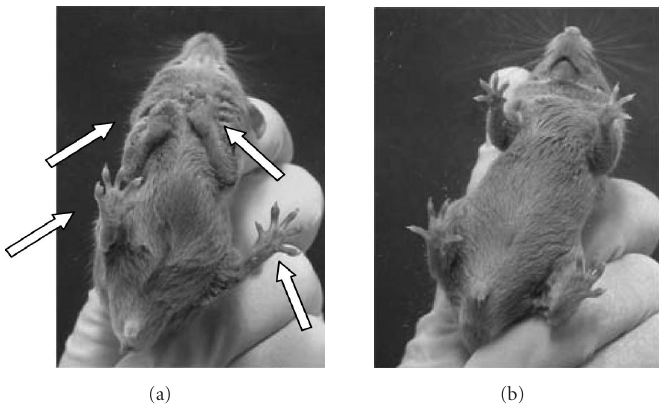
Figure 7: Macroscopic arthritis of control mice and that of geranium-treated mice. The mice were treated as represented in the legend to Figure 5 and their feet were observed on day 39. Arrows indicate the swelling of foot. (a) Control mouse; (b) mouse administered with 5 μ L geranium oil.